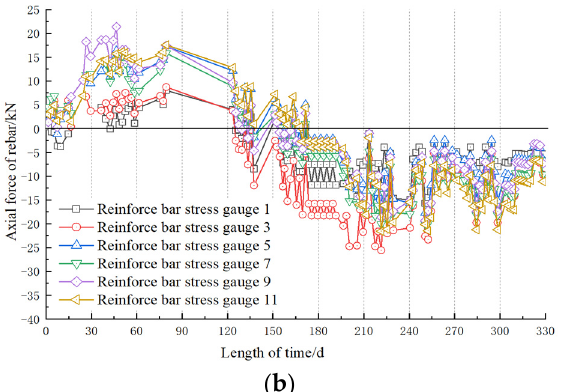
Figure 20. Reinforcement axial force curve of the top beam. ( a ) side slopes on the toppling rock side; ( b ) side slopes on the bedding rock side.